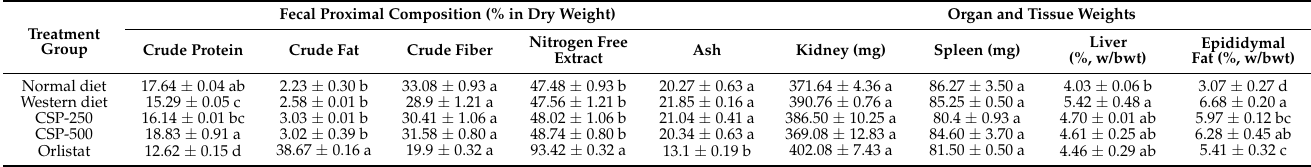
Table 1. Proximal composition of fecal matter, organ and epididymal fat weight as percentage of body weight in C57BL/6J mice after 8 weeks of